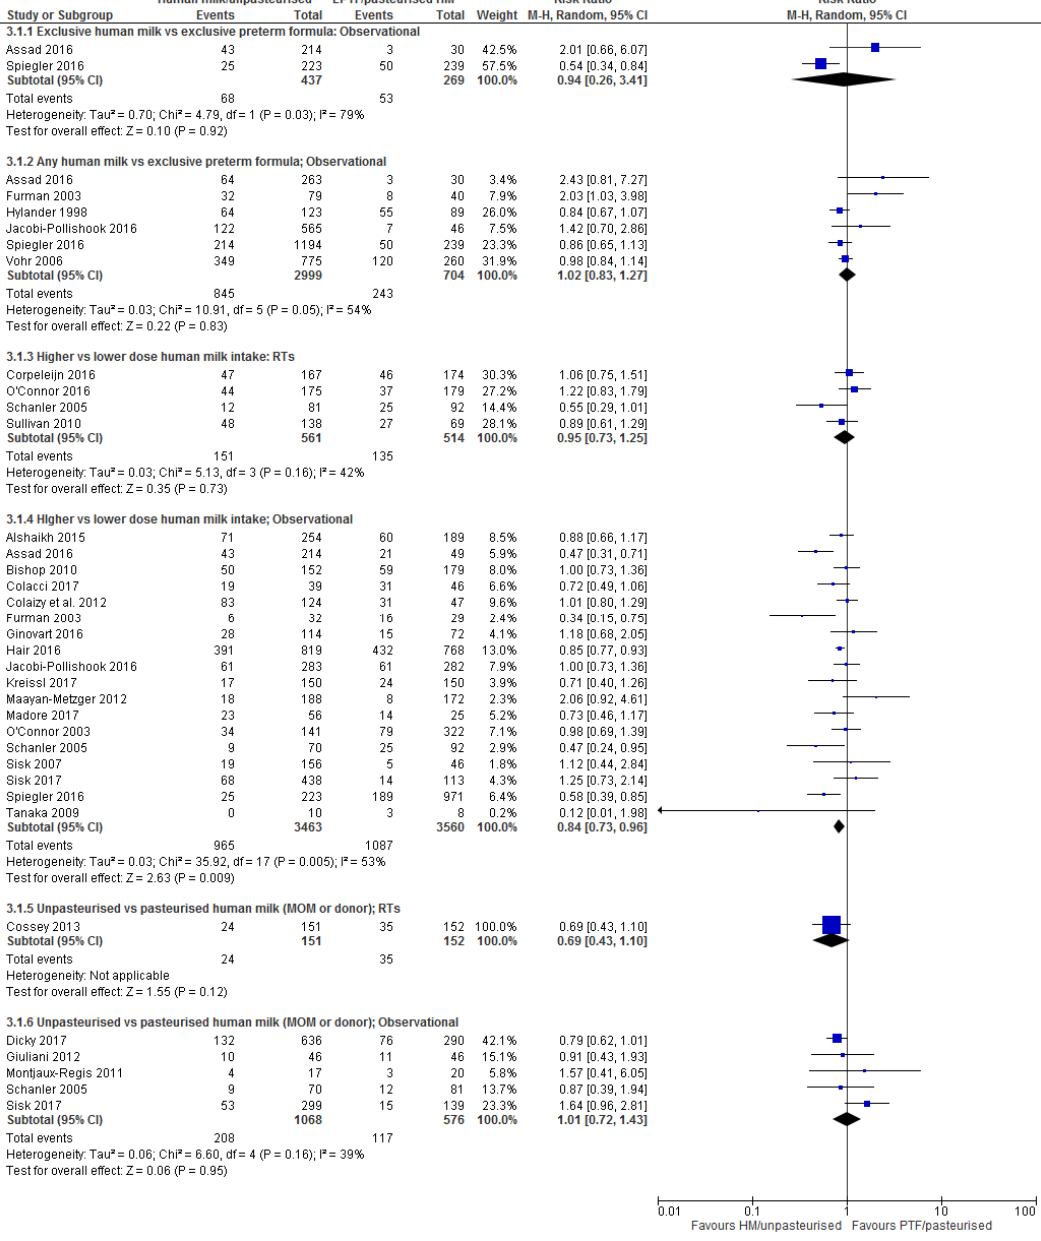
Figure 3. Forest plot of relative risk for the association between human milk and bronchopulmonary